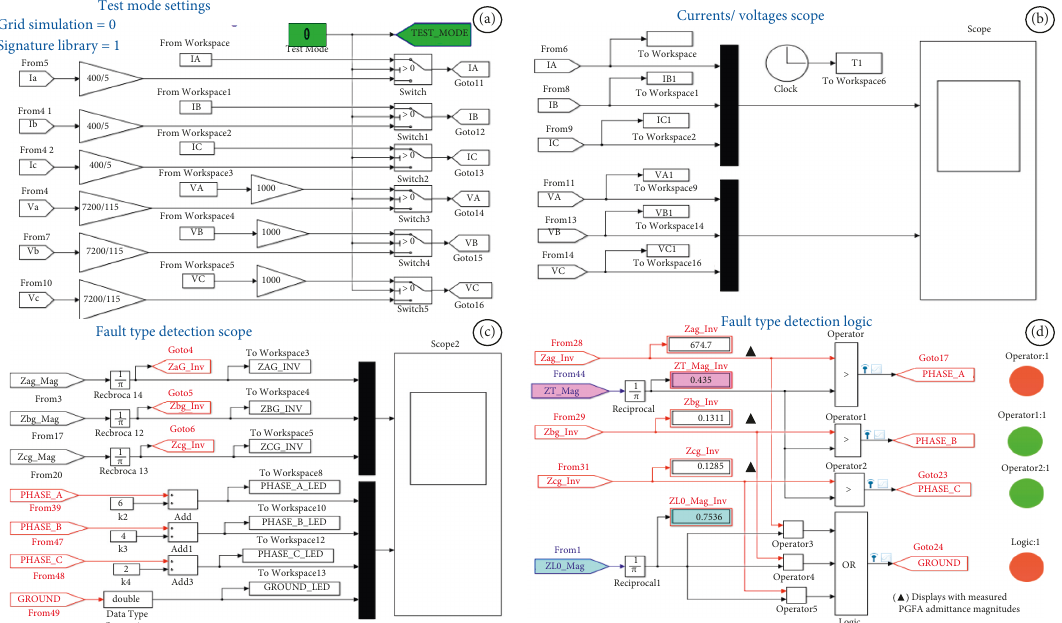
Test mode settings